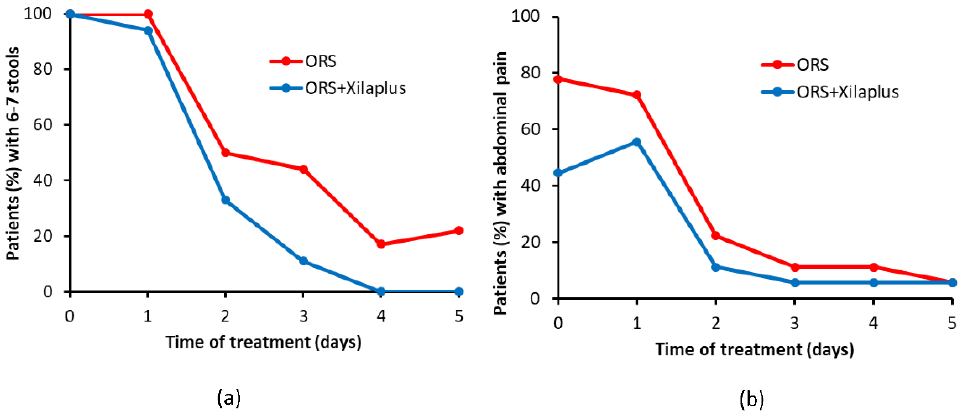
Figure 7. Evolution of some clinical symptoms of gastroenteritis during the 5-day period, comparing the treatment with oral rehydration solution (ORS) and treatment with XG and ORS (Xilaplus + ORS). ( a ) Percentage of patients with diarrhea (stools at 6/7 on the Bristol scale); ( b ) percentage of patients with abdominal pain. (Adapted from Condratovici et al. [106], with permission from the Hindawi Editorial Office.)